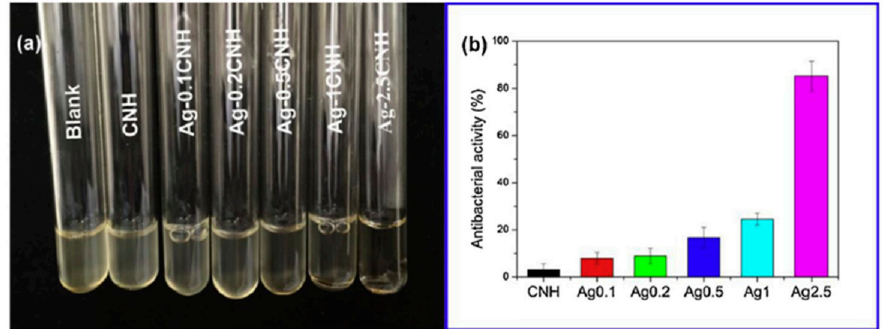
Figure 12. ( a ) Photographs associated to bacterial suspensions of a media containing an E-Coli strain co-cultured with chitin-silver nanoparticles, Ag-CNH. ( b ) Results of the evaluation of antibacterial activity obtained after measuring the optical density of the solutions at 600 nm. (Figure reproduced with permission from Reference